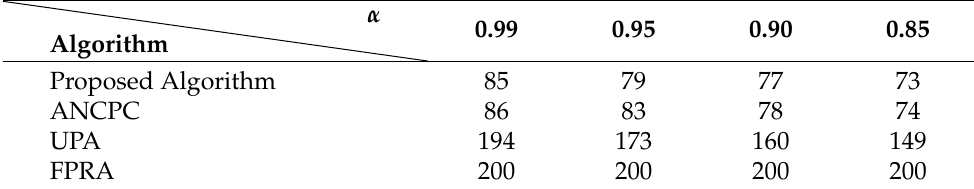
Table 2. Comparison of total power of radar